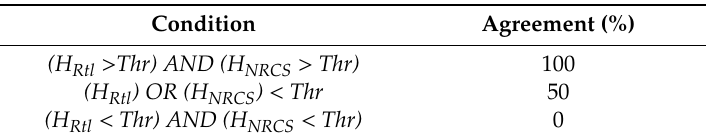
Table 4. The agreement index indicates the agreement between the modified rational and NRCS models. The H Rtl and H NRCS are the runo ff depths estimated by the rational and NRCS methods, respectively, and Thr is the threshold depth equal to 5